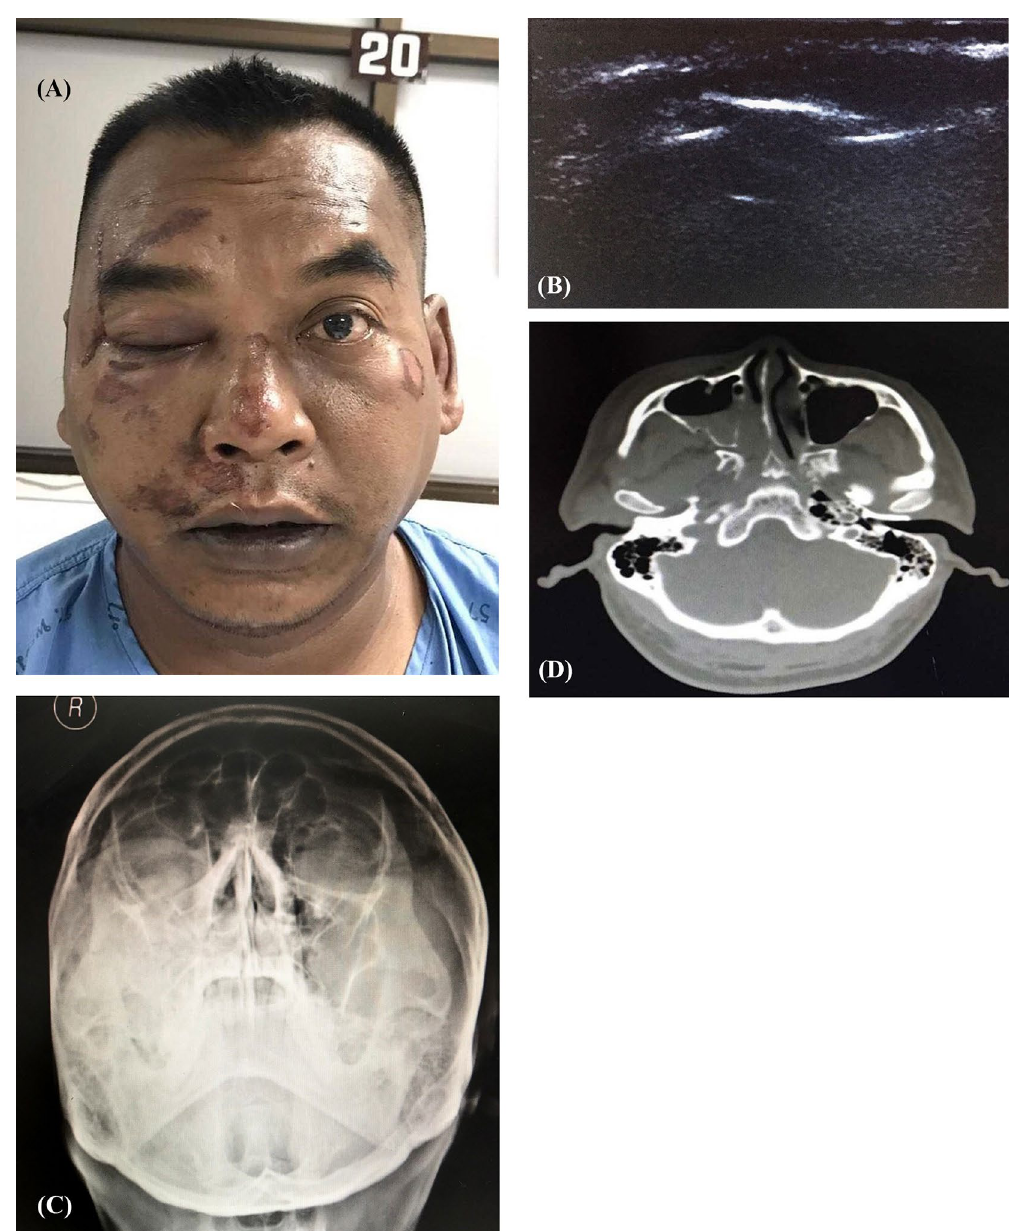
Fig. 3 a – d Case of 42-year-old male: history of vehicle accident, presented with right infraorbital rim tenderness; diagnosed with fracture of right